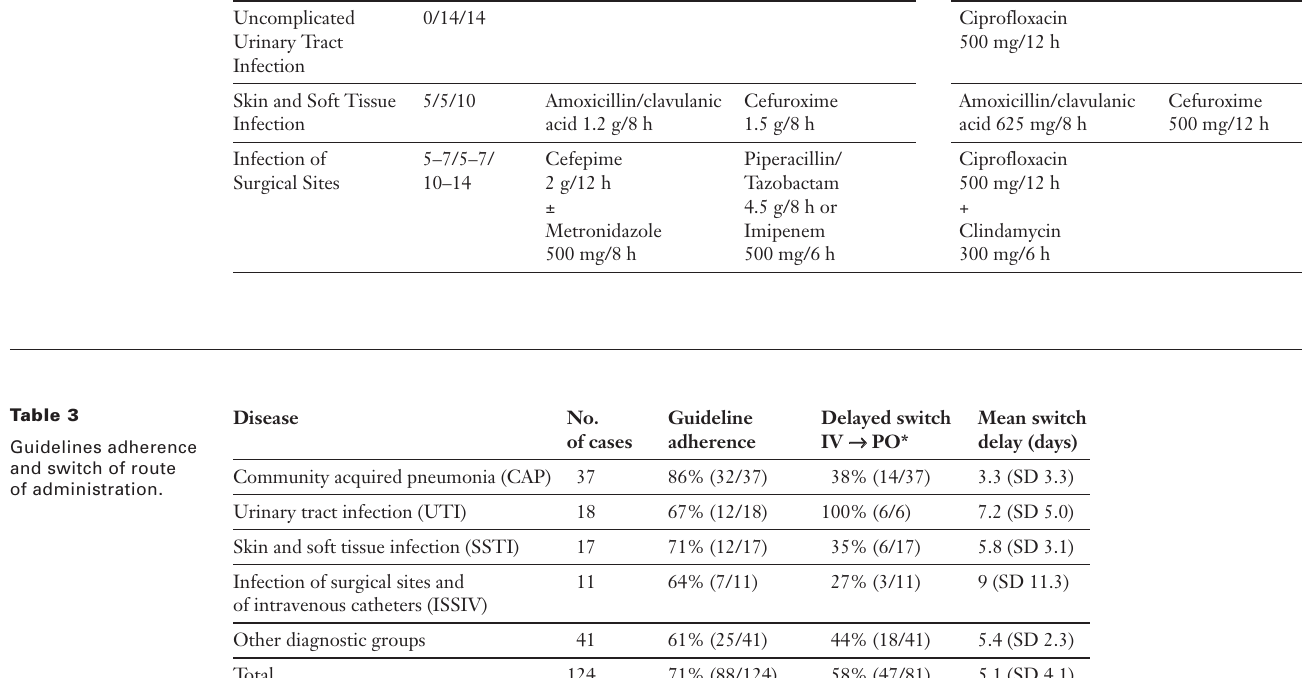
Antibiotic recommen- dation for the four most frequent thera- peutic groups derived from the local guidelines.